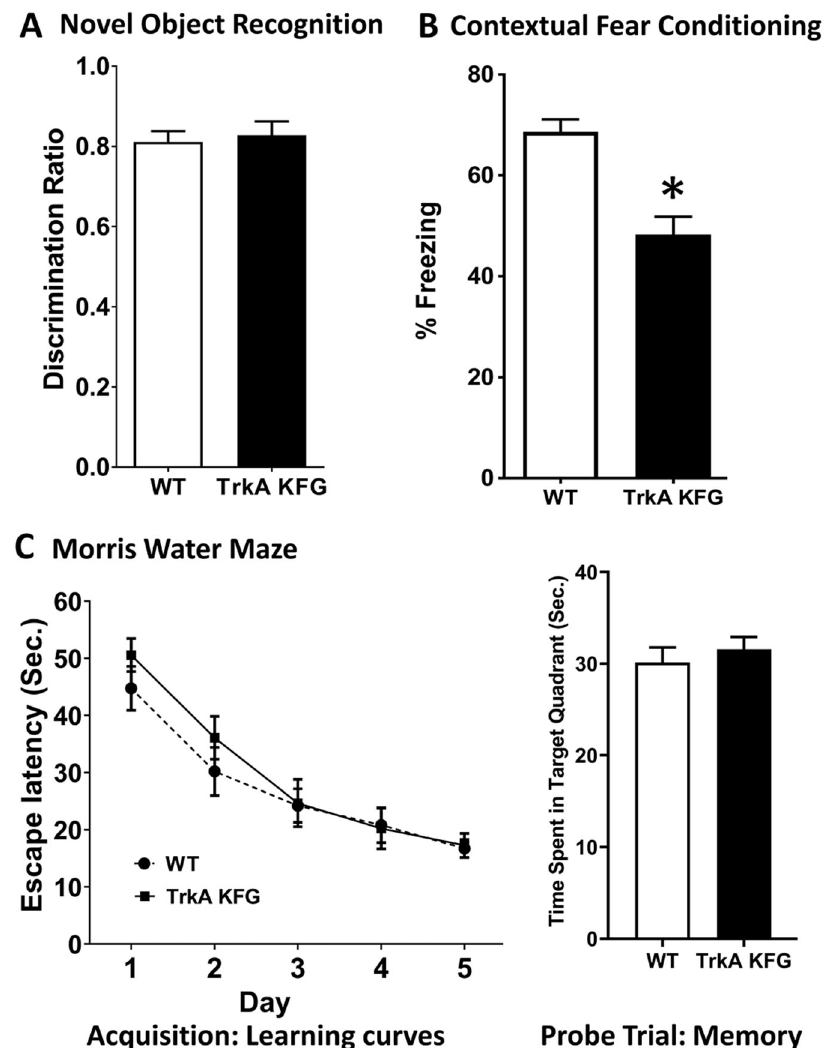
Fig. 2 CNS TrkA upregulation selectively attenuates fear expression. TrkA-KFG mice have speci fi c alterations in contextual fear conditioning. A Graphical representation of the novel object recognition test showing that WT and TrkA-KFG mice spend the same amount of time in exploring the novel versus the familiar object expressed as discrimination ratio ( n = 8/group). B Graph showing that the TrkA-KFG mice have reduced freezing response in contextual fear conditioning test (% Freezing 68.63 ± 2.48 in WT and 48.26 ± 3.56 in TrkA-KFG, n = 8/group). C Results from the Morris Water maze test showing that both escape latency (left panel; time to locate the submerged platform) during the acquisition trial for spatial learning as well as the time spent in in the quadrant where the platform was previously located during the probe trial (right panel) for spatial reference memory are similar in WT ( n = 15) and TrkA-KFG ( n = 14) mice. Statistical analysis by Mann – Whitney test. * p <